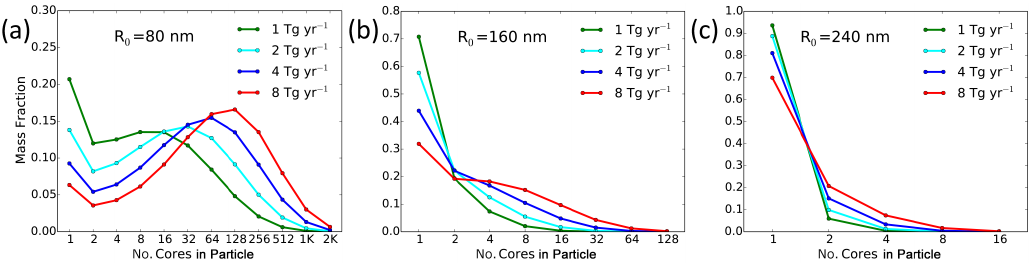
Figure 4. Calculated global annual average stratospheric mass fractions of alumina as a function of the number of monomers contained in a fractal particle for (a) monomer injections of 80nm radius, (b) monomer injections of 160nm, and (c) monomer injections of 240nm radius, with emission rates ranging from 1 to 8Tgyr − 1